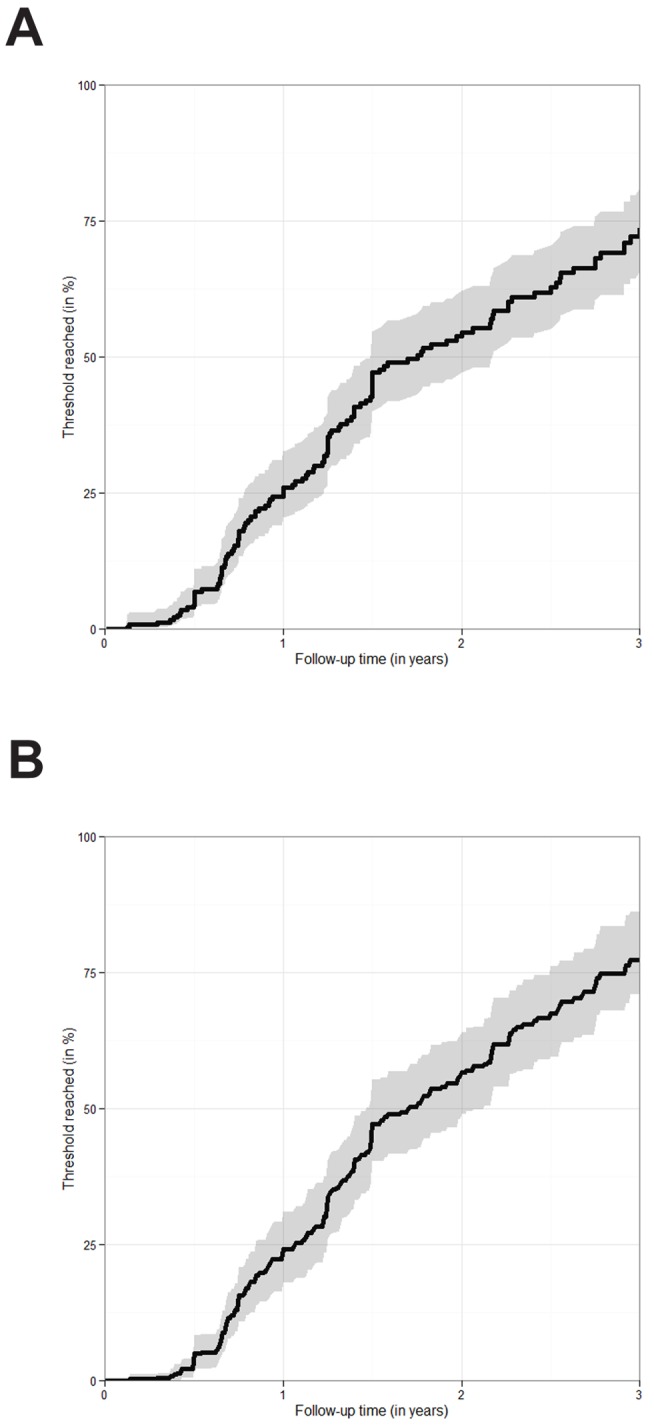
Estimated probability of falling below a CD4 count of 750 cells/mm3 or a CD4 percentage of 25%.(A) Time to fall below the CD4 threshold of a CD4 count of 750 cells/mm3 or a CD4% of 25% estimated via the Kaplan-Meier estimator. The figure is based on 322 children presenting with a CD4 count of 750 cells/mm3 or above and a CD4% of 25% or above. Only pre-ART follow-up is considered. 95% confidence intervals are visualised via the grey shaded area. (B) Time to fall below the CD4 threshold of a CD4 count of 750 cells/mm3 or a CD4% of 25%. The figure is based on 322 children presenting with a CD4 count of 750 cells/mm3 or above and a CD4% of 25% or above. ART initiation, death, and LTFU were treated as competing risks. The probability of falling below the threshold was estimated via the cumulative incidence of falling below the threshold before any other event occurred divided by one minus the probability that any other event occurred before the threshold was reached. 95% confidence intervals were obtained via bootstrapping and are visualised via the grey shaded area.